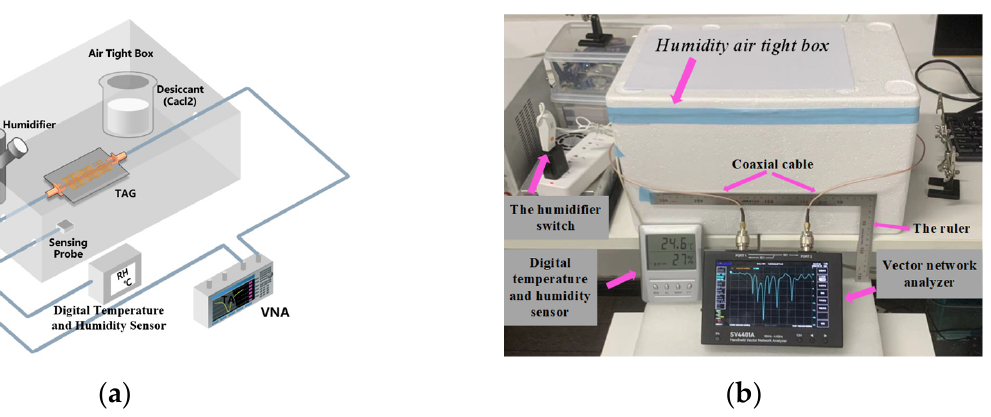
Figure 9. Tag humidity test scenarios: ( a ) Three-dimensional modeling experiment scene simulation; ( b ) Experimental testing of humidity in a laboratory environment.